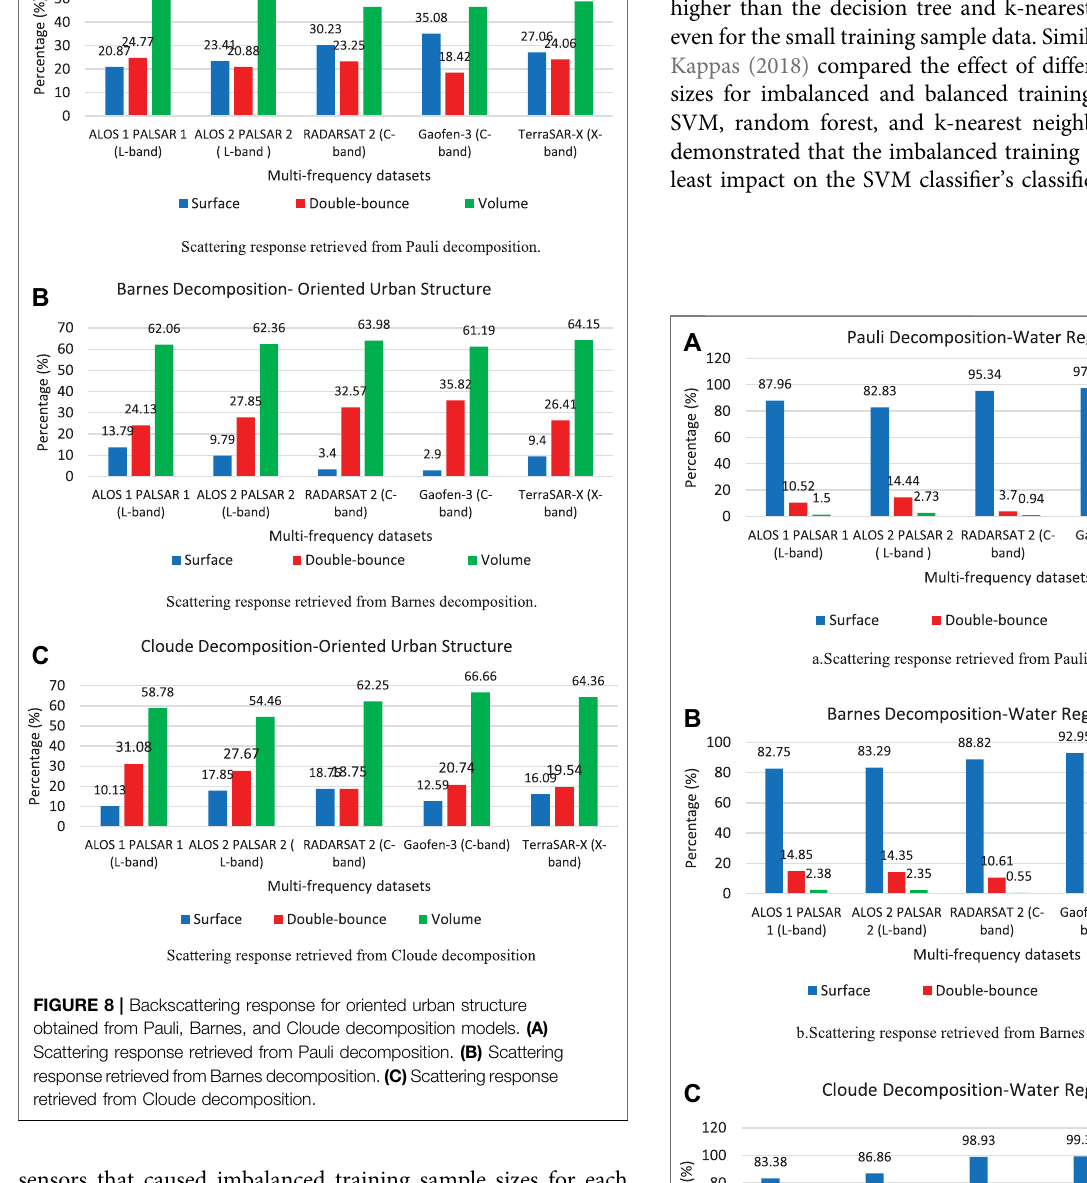
Frontiers in Earth Science |